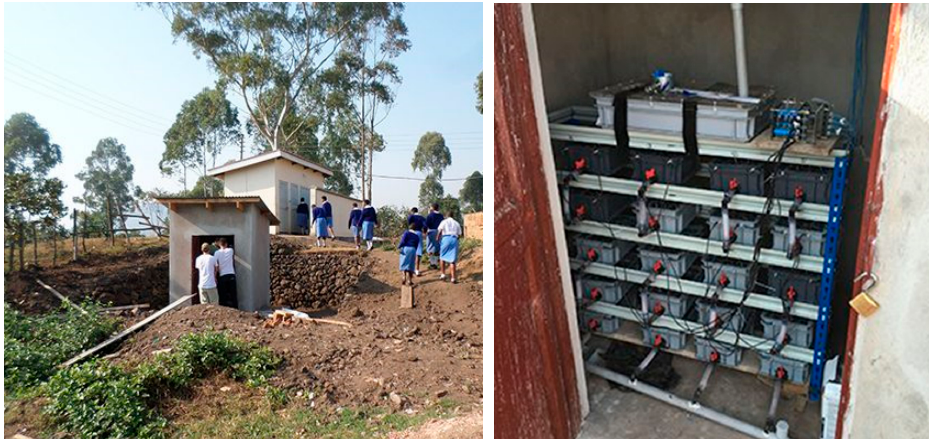
Figure 2. Photographs of Pee Power installation site (left) and system (right). In the left photo, building block located on the lower ground is where the Pee Power system was installed. The building on upper ground is an existing toilet block of the Seseme Girls’ Secondary School.